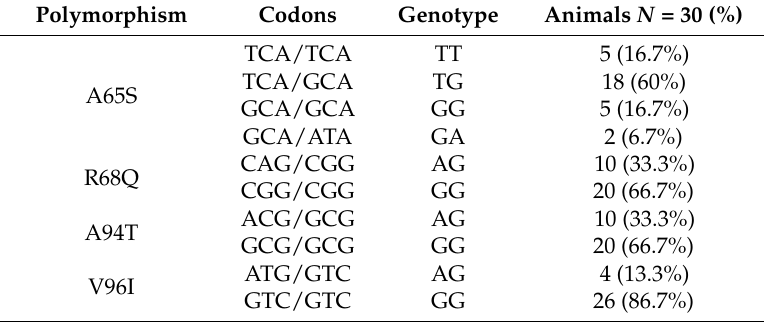
Table 1. Polymorphisms, genotypes and frequencies in the A3Z3 from feline immunodeficiency virus (FIV) positive cats in Porto Alegre